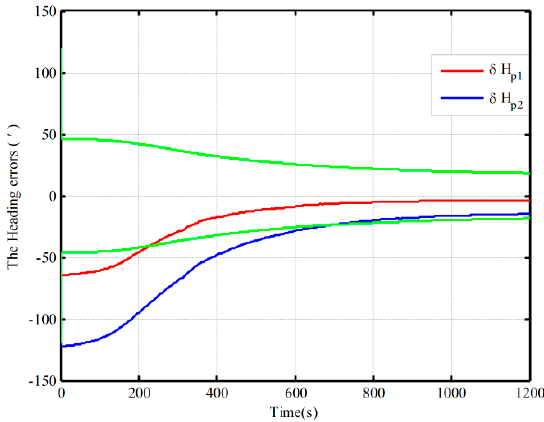
Figure 14. The polar closed-loop KF alignment at 89° latitude.